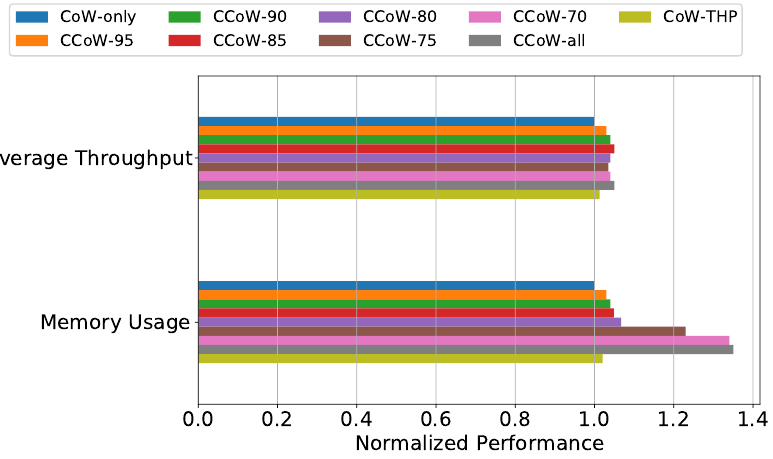
Figure 7. Overall performance of the Redis with